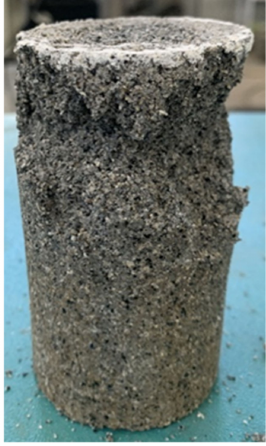
Figure 6. Sample stabilized by composite stabilizer after UCS